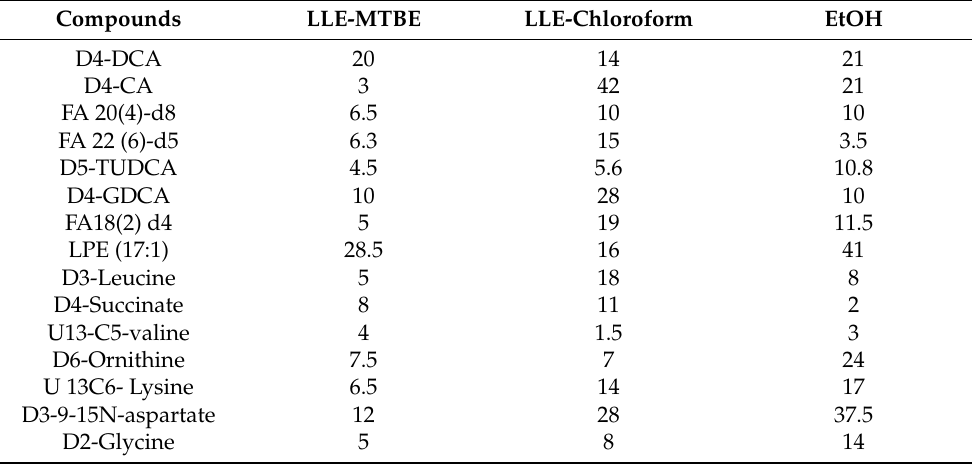
Table 1. The coefficient of variation (CV%) for peak areas of 15 stable-isotope labeled standards spiked in fecal samples for MTBE, chloroform and ethanol extraction protocols in negative ESI using untargeted